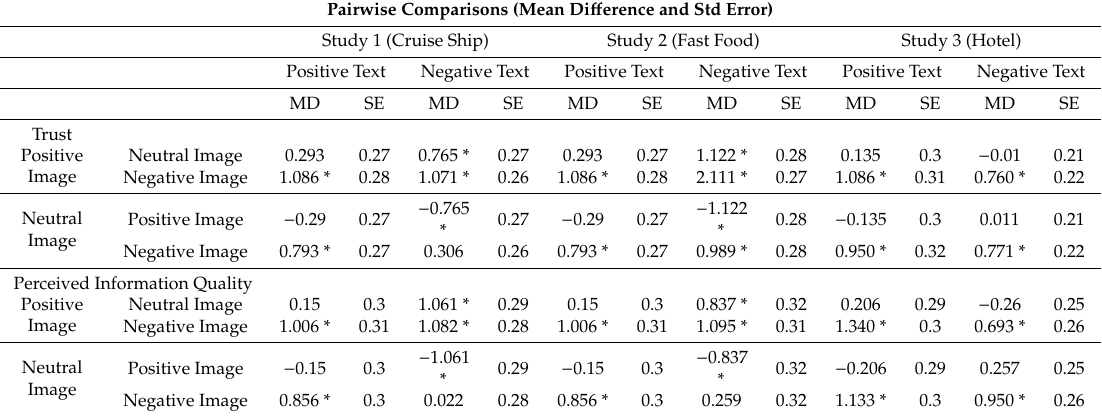
Table 2. Presents the pairwise comparisons for the positive and negative text reviews for all studies. For both negative and positive texts, the results for Study 1 show significant findings for a di ff erence between no disparity and high disparity, but no significant di ff erence at the 0.05 level for moderate disparity. The results for Study 2 show significant findings for a di ff erence between no disparity and high disparity, and like Study 1, the positive reviews also showed no significant di ff erence at the 0.05 level for moderate disparity; however, the negative reviews showed significance for both moderate and high disparity. The results for study 3 reflect Study 1, in that for both negative and positive reviews, the results show significant findings for a di ff erence between no disparity and high disparity, but no significant di ff erence at the 0.05 level for moderate